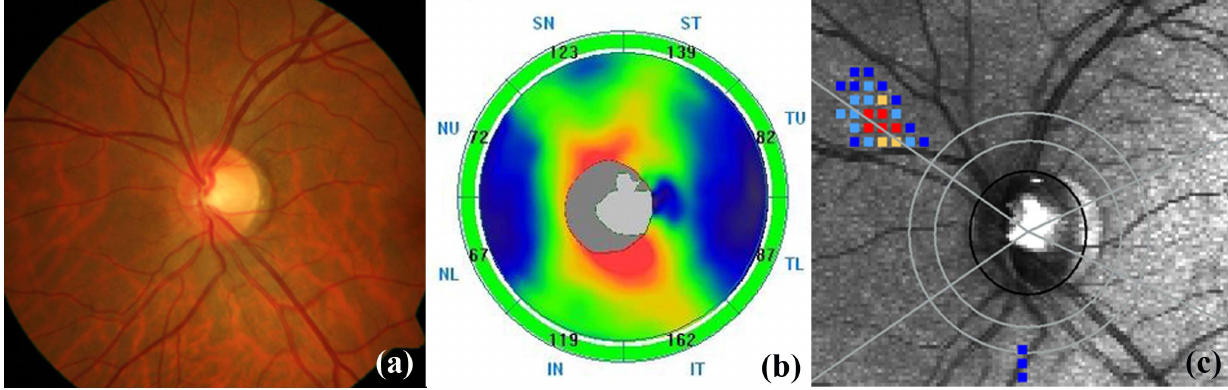
Figure 1. Representative image of an eye in the control group showing normal optic disc and retinal nerve fiber layer (RNFL) on disc photograph (a), normal RNFL thickness on spectral domain optic coherence tomography (b) and normal RNFL birefringence on GDx enhanced corneal compensation (c). doi:10.1371/journal.pone.0108992.g001 PLOS ONE |